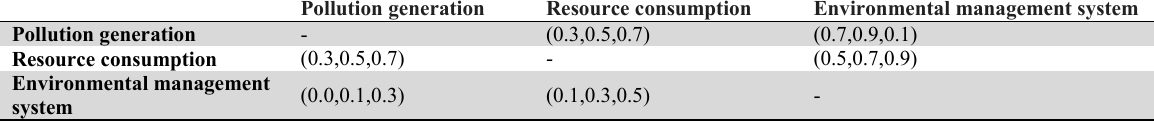
The relative importance of environmental benefits criterion when green design criterion is under control